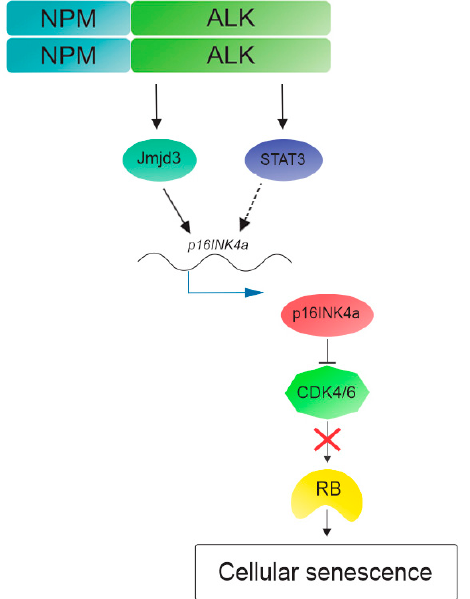
Figure 2. Cellular senescence pathway activated by NPM-ALK. NPM-ALK promotes oncogenic- induced senescence through de-methylation of p16INK4a promoter performed by Jmjd3. Multiple mechanisms participate in p16INK4a activation, including signal transducer and activator of transcription 3 (STAT3). Then p16INK4a inhibits cyclin-dependent kinase 4 and 6 (CDK4/CDK6) allowing for retinoblastoma (RB) to induce cellular senescence and cell cycle arrest.